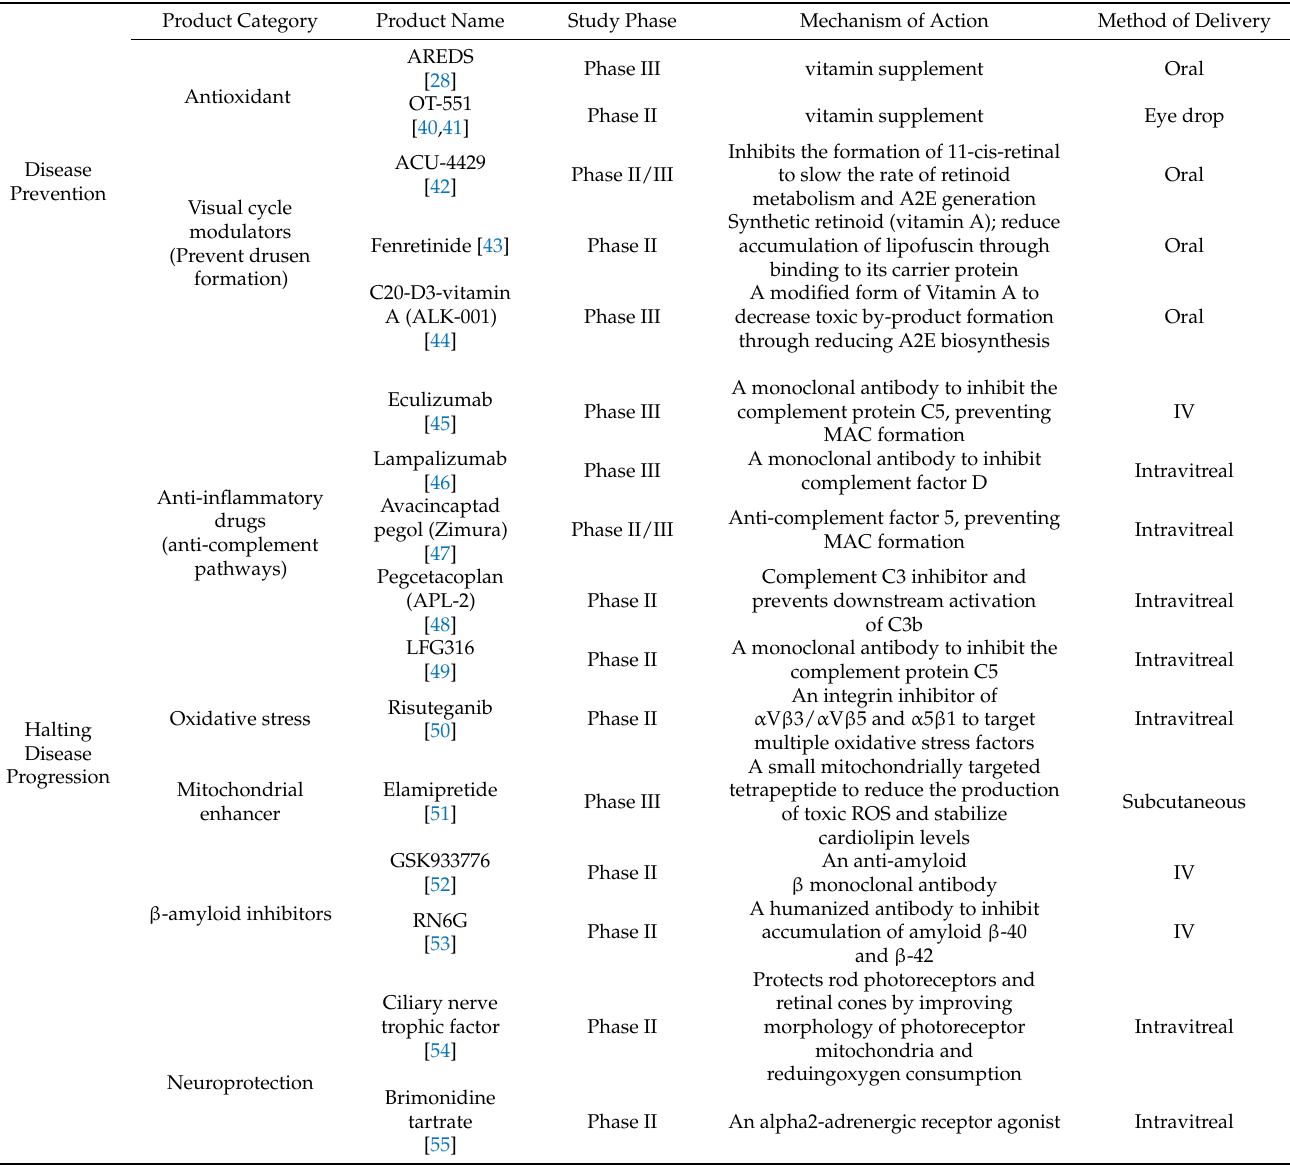
Table 1. List of potential treatment options in clinical trials for dry-AMD, focusing on disease prevention and halting disease